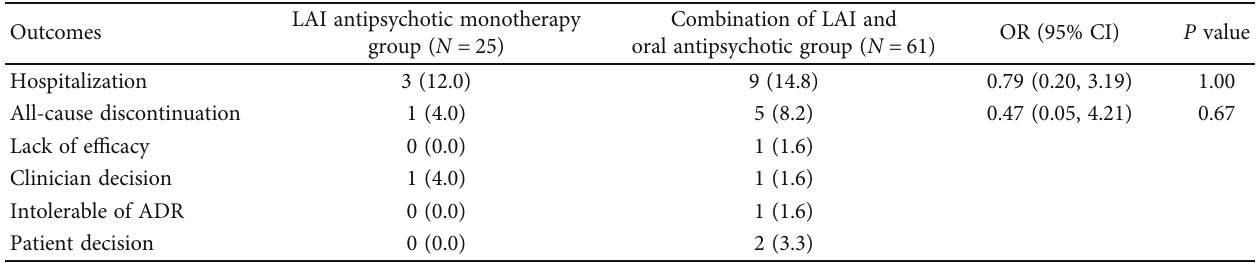
0 (0.0) Table 3: Adverse drug reactions between the LAI antipsychotic monotherapy and combination of LAI and oral antipsychotic groups. Adverse drug